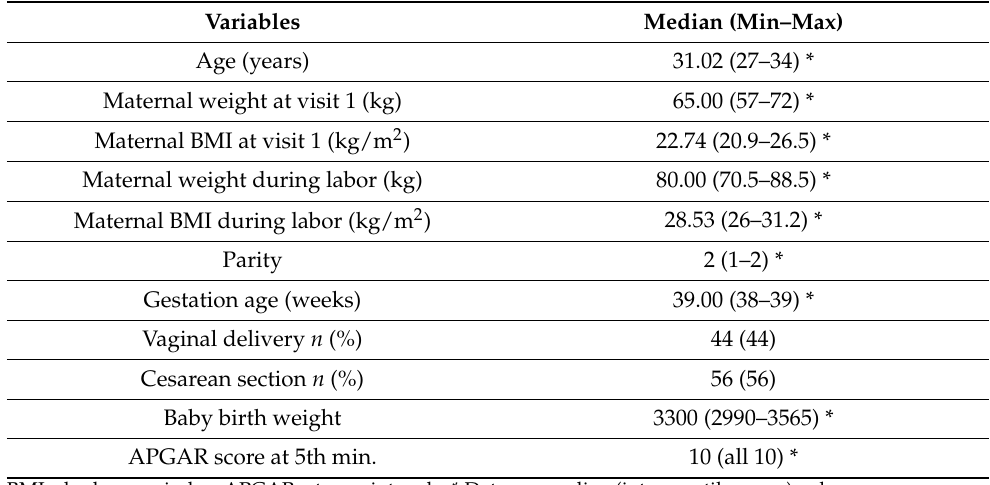
Table 1. Clinical characteristics of the analyzed group ( n =